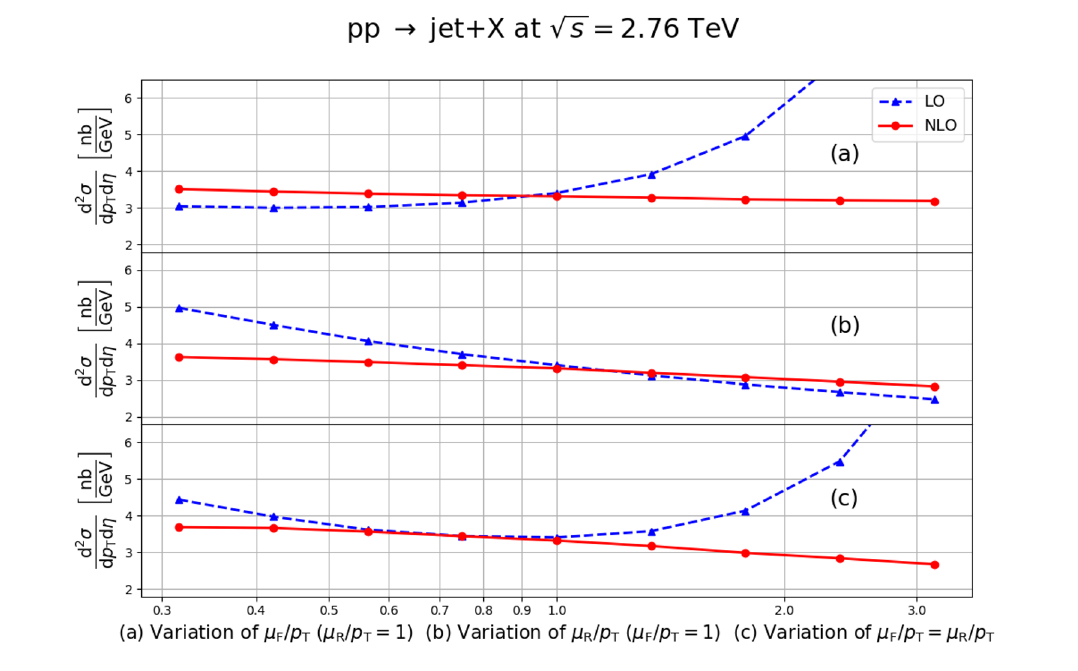
Figure 2 . Dependence of the differential cross section for inclusive jets with radius R = 0 . 4 , transverse momentum p [70; 80] GeV and rapidity | η | < 2 . 0 on the factorisation scale (top), T ∈ renormalisation scale (centre) and both scales (bottom) at LO (blue curves) and NLO (red curves). All jets within one event that satisfy the acceptance cuts contribute to the cross